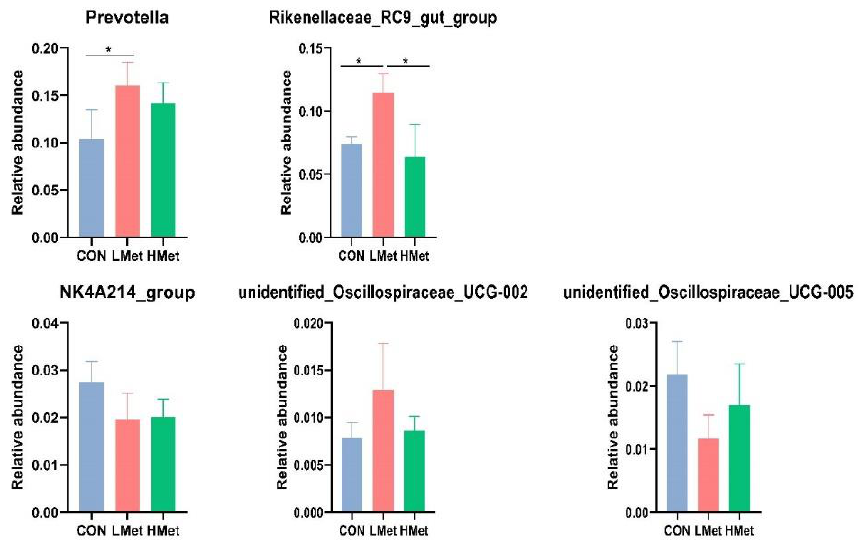
Figure 4. Bacterial analysis in genus-level differences in sika deer (* indicates p < 0.05).